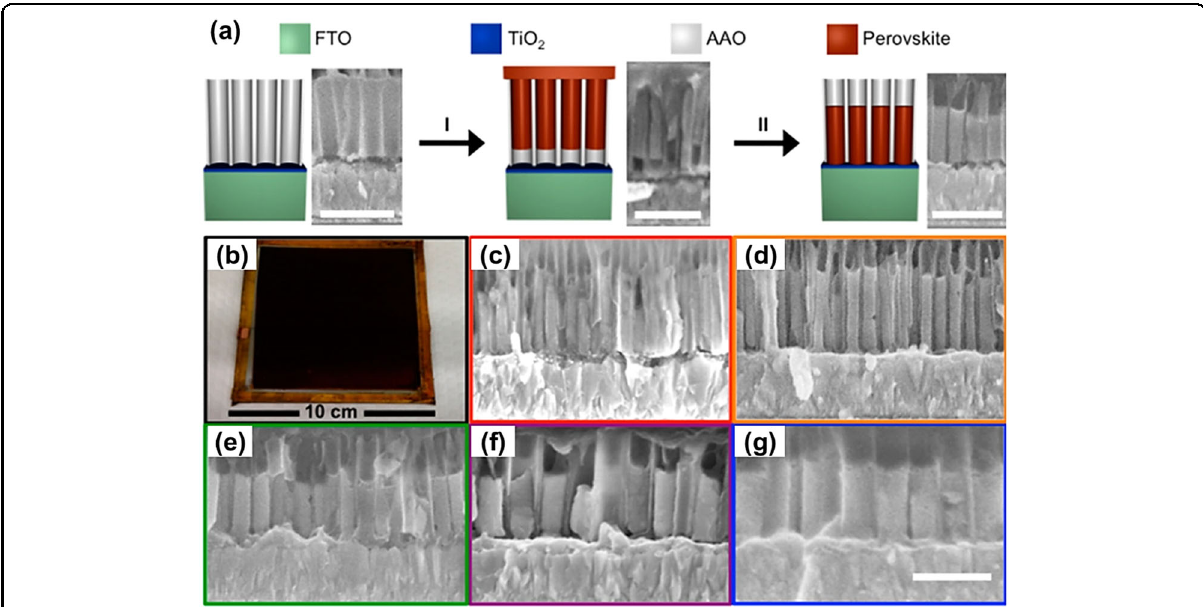
Fig. 5 Growth of 1D morphological MHP by template-assisted methods. a Scheme for the syntheses of 1D MHP NW arrays in AAO. Penetration of the precursor solution into the AAO pores (I). Dimethyl sulfoxide/chlorobenzene treatment (II). b Photograph of an NW array with a size of ~9 × 9 cm. c – g SEM images with cross-sectional views of NWs with various diameters. Reproduced with permission from ref. 63 . Copyright 2016, American Chemical